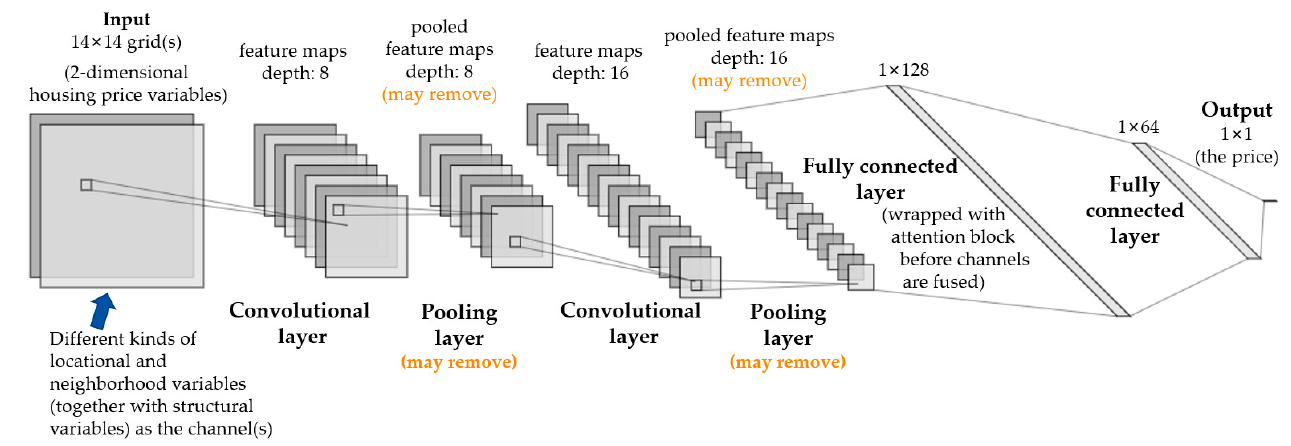
Figure 4. The structure of the CNN model for the rental housing